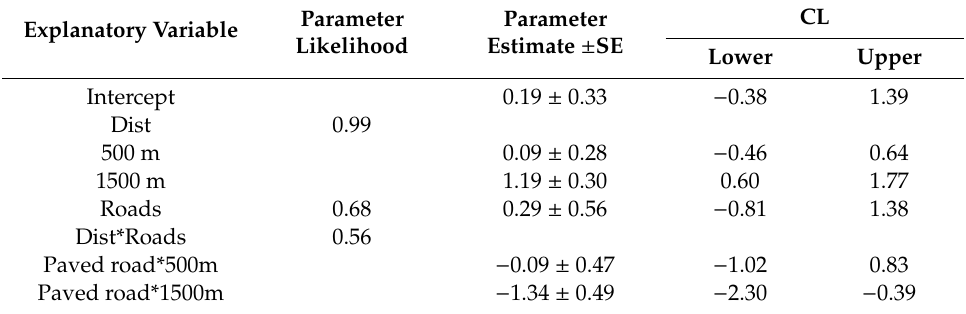
Table 2. Parameter likelihoods, estimates ( ± standard error (SE)) and 95% confidence interval limits (CL) for explanatory variables describing guanaco spatial use intensity: considering the minimum distance to the closest road in meters (Dist), the kind of roads (Roads) and their interaction (Dist*Roads). Explanatory